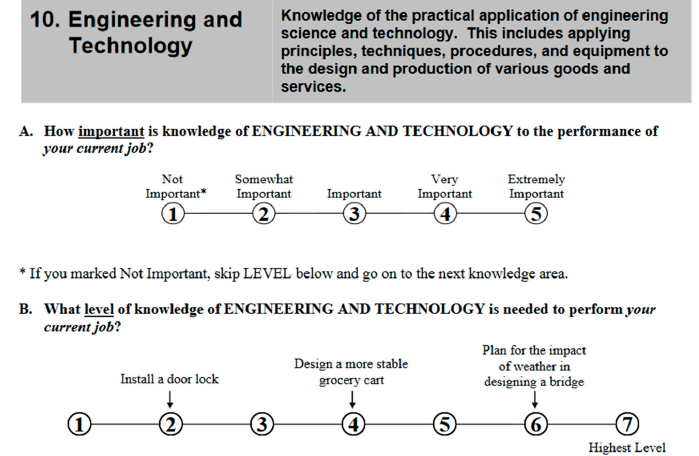
Figure 1. Sample knowledge item from the O*NET Knowledge Questionnaire.